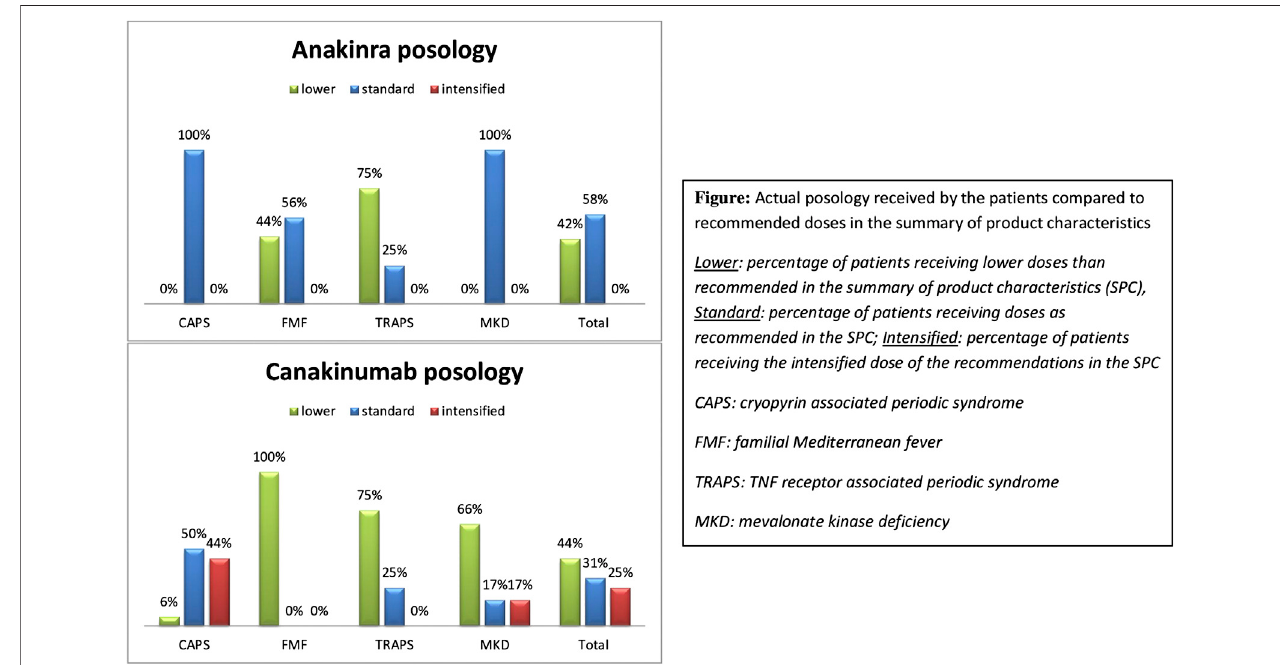
FIGURE 1 | Actual posology received by the patients compared to recommended doses in the summary of product characteristics.